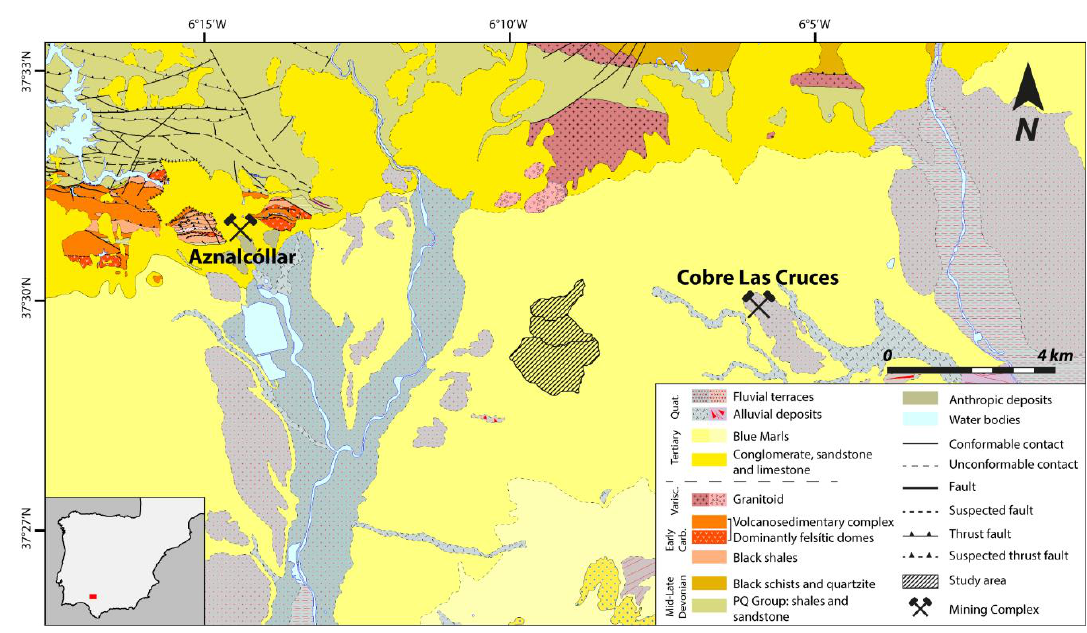
Figure 2. Study area and geological map of the northern section of the Guadalquivir basin (adapted from IGME, Instituto Geológico y Minero de España, 2008 [20]).